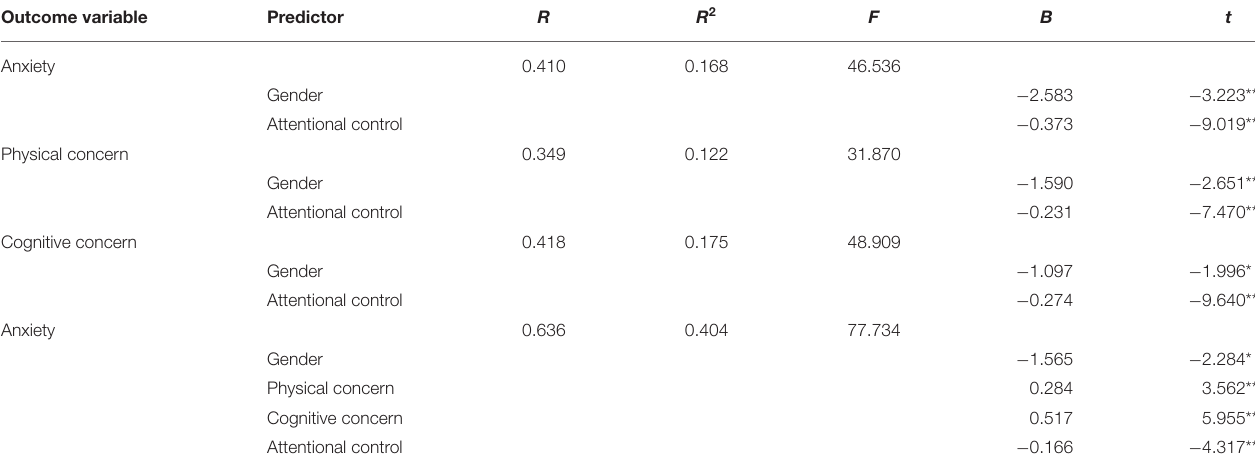
TABLE 3 | Regression analysis of relationships among model variables. Outcome variable